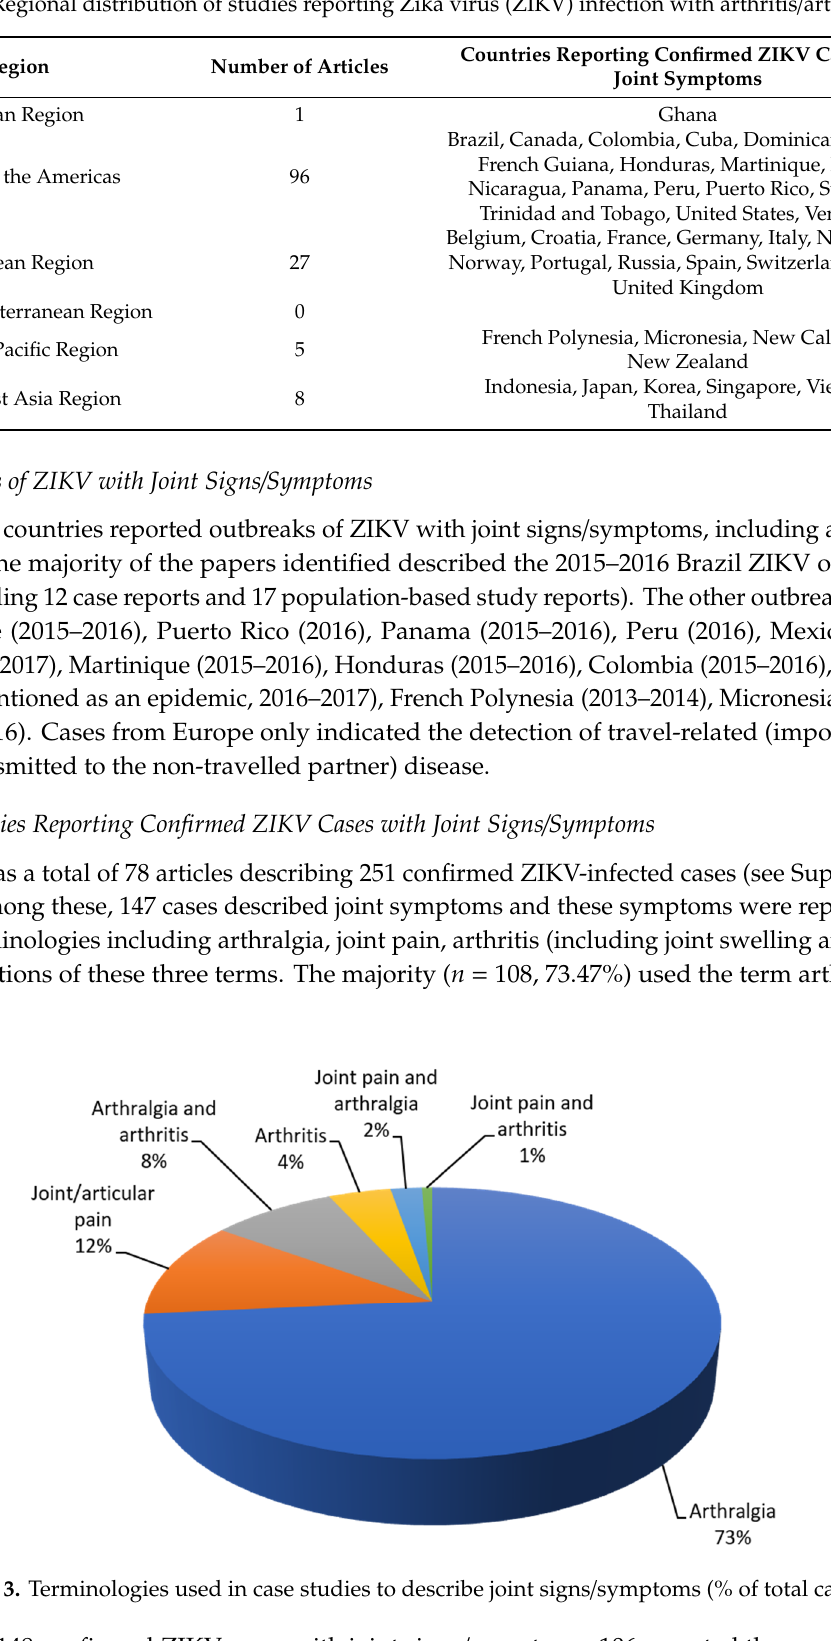
Table 3. Regional distribution of studies reporting Zika virus (ZIKV) infection with arthritis/arthralgia.